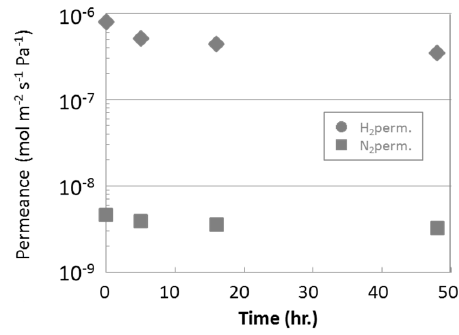
Figure 10. Steam durability evaluation of HMDSO-derived membrane